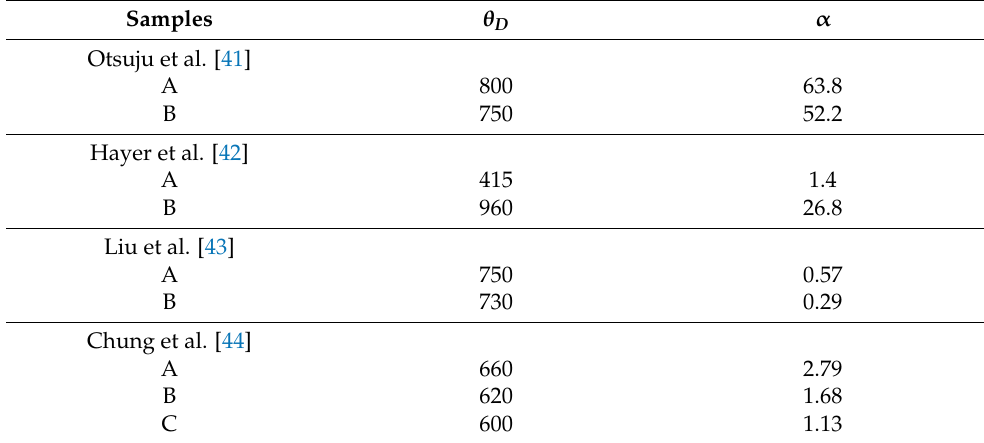
Table 1. Experimental data published in previous reports of thermally introduced resistance from current-voltage measurements with different kind of heterostructure configuration for estimation of the Debye temperature and electron–phonon